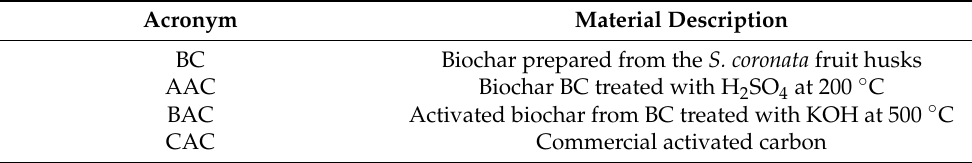
Table 1. Summary of the materials evaluated in this